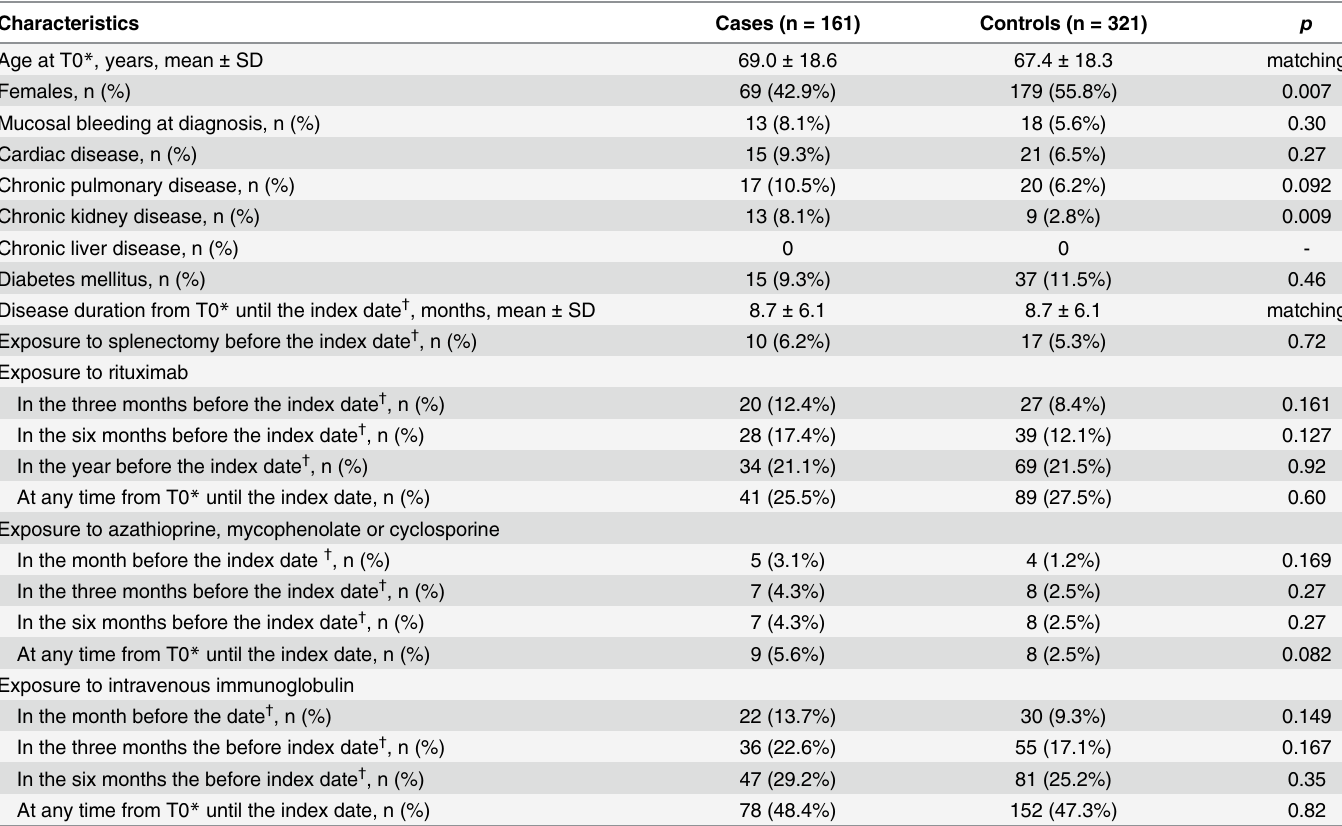
Table 1. Cases ’ and controls ’